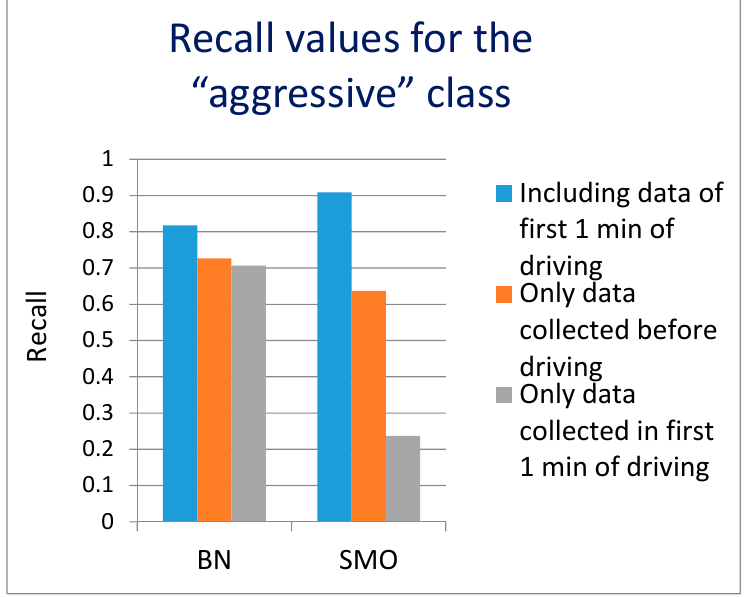
Figure 7. The values of recall for aggressive driving for different data sets and algorithms.